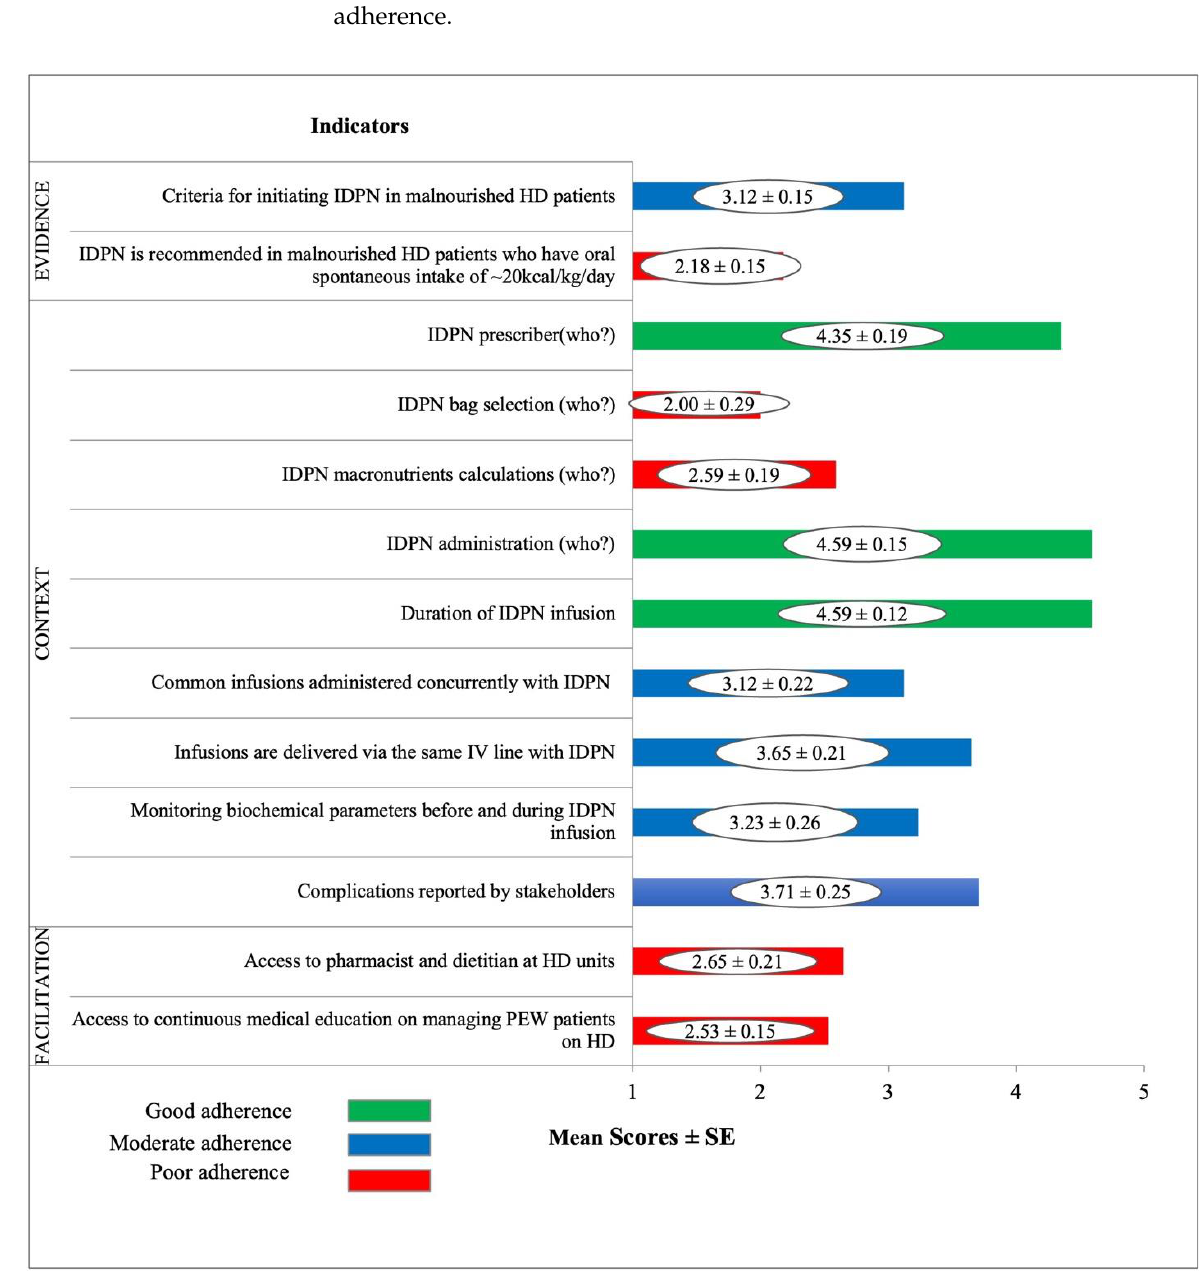
Figure 2. Mean ±SE Score Ratings from Experts as per Indicators and PARIHS Domains. Abbrevia- tions: HD, Hemodialysis; IDPN, Intradialytic Parenteral Nutrition; IV, Intravenous; PEW, Protein Energy Wasting.